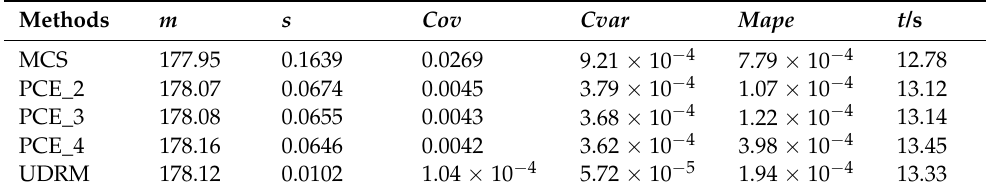
Table 6. Evaluation table of different UQ methods under 50% uncertainty of sheath resistivity under short-circuit fault.